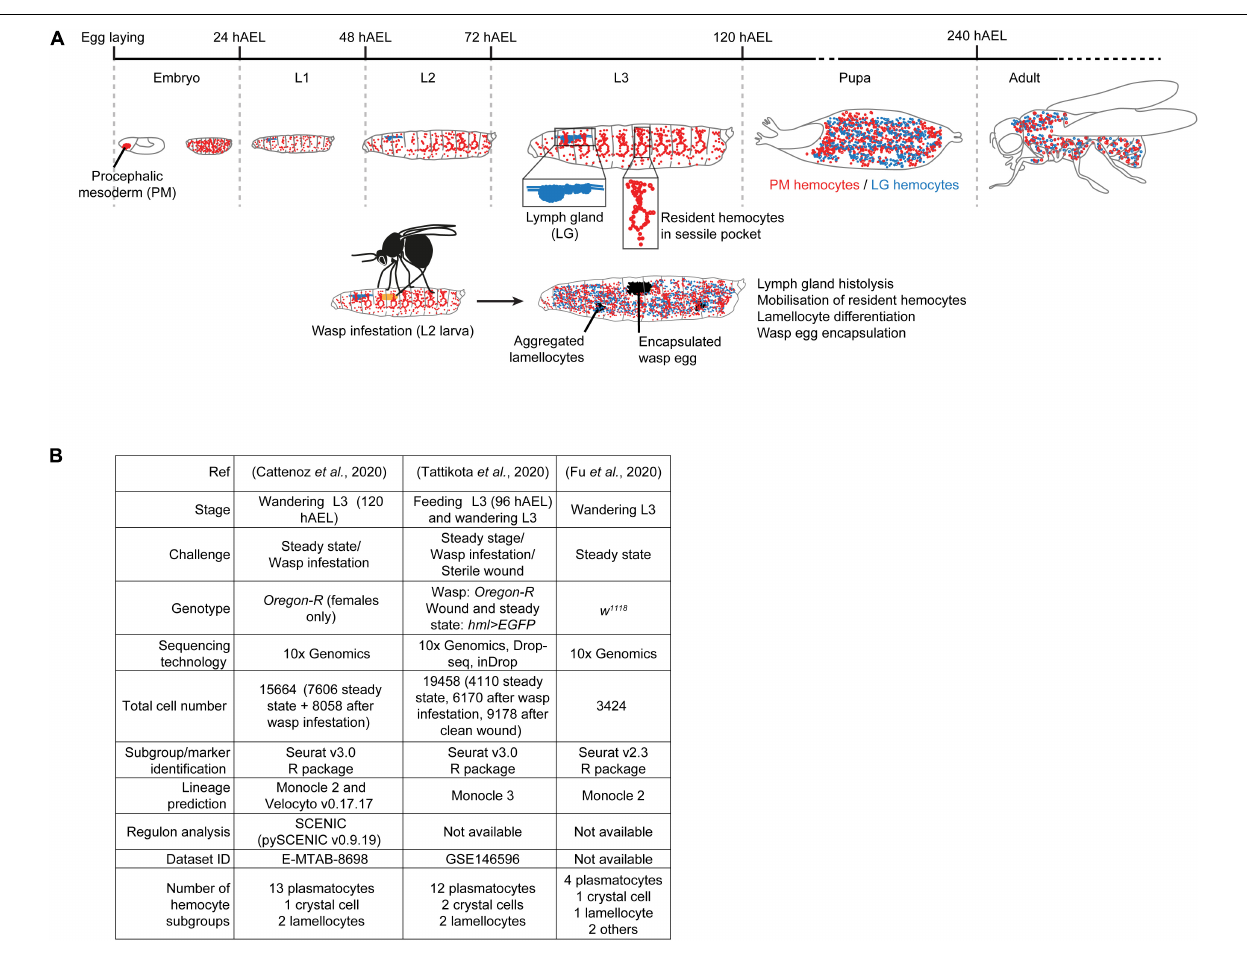
FIGURE 1 | Experimental procedures used to generate the scRNAseq datasets on larval hemocytes. (A) Overview of the two hematopoietic waves during Drosophila development. The first wave starts in the procephalic mesoderm (PM) of the early embryo. By the end of embryogenesis, the PM hemocytes spread across the whole embryo and constitute the whole population of hemocytes present in the hemolymph of the larva. By the 2nd larval instar, the majority of the PM hemocytes become resident between the muscle and the cuticle to form the sessile pockets. After pupariation, the hemocytes are mobilized in the hemolymph. The second wave occurs in the lymph gland (LG) during the larval stages, the LG hemocytes being released in circulation after pupariation. When the wasp infests the larva (2nd instar), it induces a strong immune response, which includes precocious lymph gland histolysis and the release of the LG hemocytes in 3rd instar larvae. The response also includes the mobilization of the resident hemocytes and the differentiation of lamellocytes to encapsulate the wasp egg. The lamellocytes spontaneously aggregate and form melanized masses called melanotic tumors. The developmental stages and their duration at 25 ◦ C are indicated in gray in hours After Egg Laying (hAEL). (B) Experimental parameters of the three single cell sequencing analyses of PM